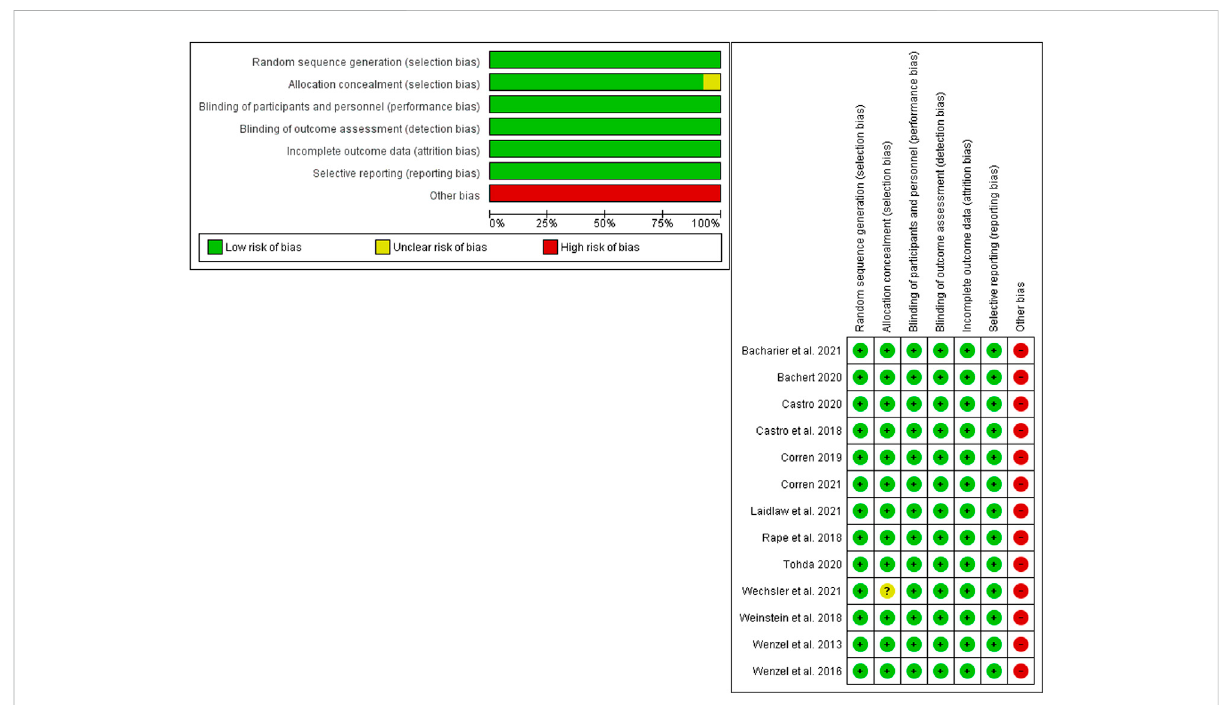
FIGURE 2 Summary and graph of risk of bias assessment results for the included studies.